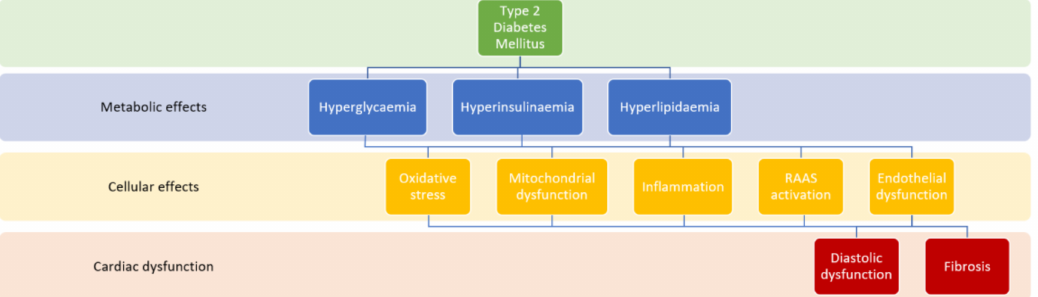
Figure 1. Pathophysiology of diabetic cardiomyopathy